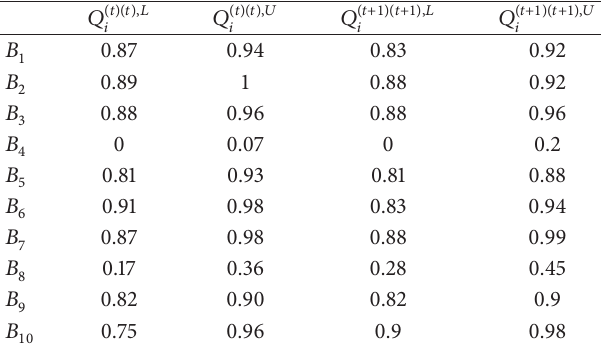
Table 16: 𝑄 interval numbers.